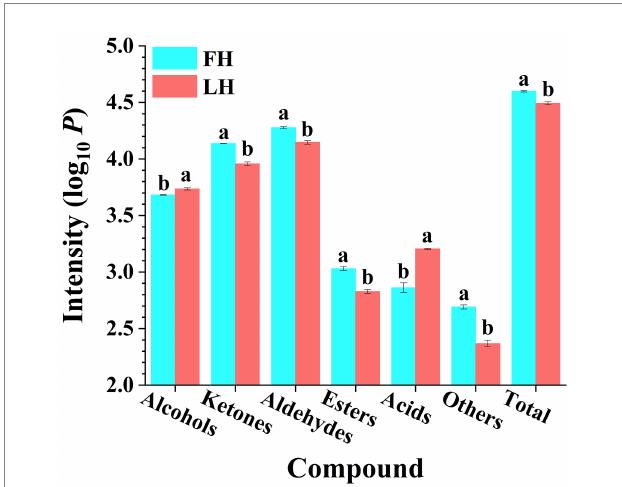
FIGURE 1 Comparison of volatile flavor compound intensities of Jinhua FH and LH in different chemical families. Different lowercases above the error bar denote significant differences between Jinhua FH and LH ( p < 0.05). FH, fatty ham; LH, lean ham. Log 10 P is the logarithmic value of total intensity for compounds of each chemical family in HS-GC-IMS